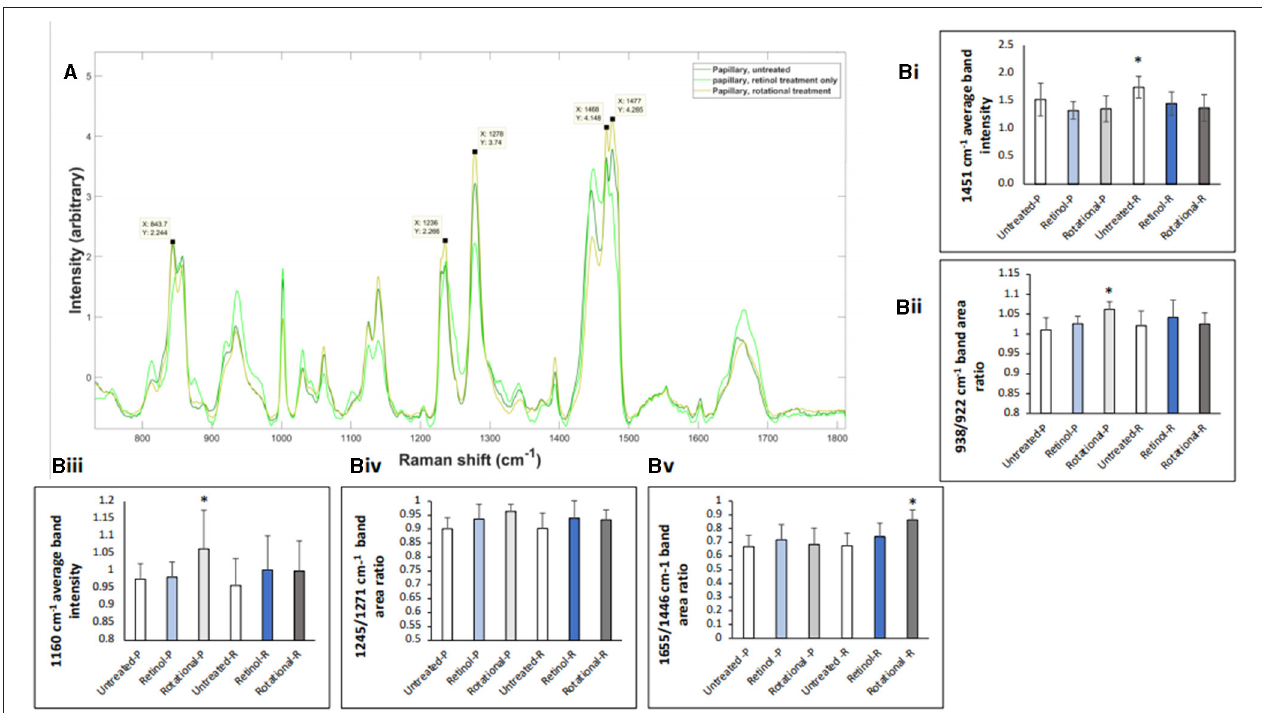
FIGURE 11 | Raman spectroscopy analysis of in vivo skin samples. Volunteers ( n = 32) received application of either 0.1% retinol formulation for 4 weeks or weekly rotation of 1% phytol/4% glycolic acid (PGA) formula with 0.1% retinol formula. Biopsy samples were taken at the end of the 4-week period, and samples were analyzed by confocal Raman. (A) Graphs represent the average spectra for all papillary dermis. Key peaks relating to collagen/protein content are labeled as described in the text. (B) Bar charts indicating key peaks. (i) The bandwidth 1,451 cm − 1 represents the CH bending mode of collagen; data collected at this bandwidth was normalized to phenylalanine (Phe) peak at 1,002 cm − 1 . The average band intensity at 1,451 cm − 1 for untreated, retinol-treated, and rotational-treated samples in the papillary (-P) and reticular (-R) layers is plotted. As the dataset was parametric, a t -test was used to demonstrate that there was a significant increase at this bandwidth in untreated samples compared to rotational in the reticular layer. * p < 0.05. (ii) The band area ratio 938/932 cm − 1 calculated in untreated, retinol-treated, and rotational-treated samples in the papillary (-P) and reticular (-R) layers accounting for proline and hydroxyproline residues of collagen and water, indicating